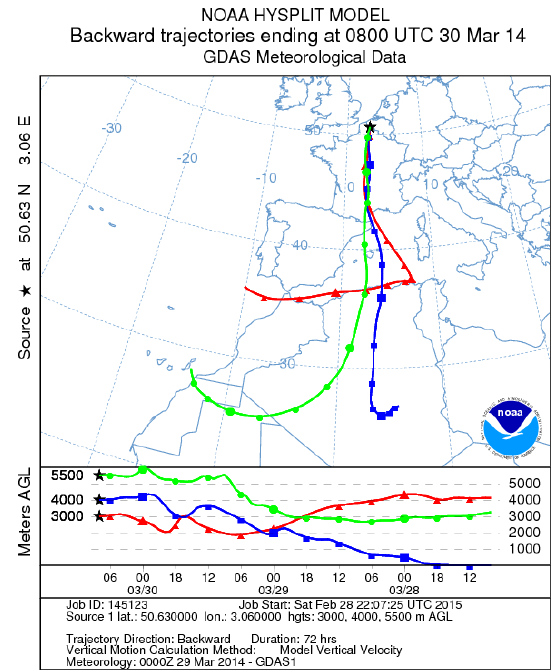
Figure 2. Backward trajectories of air masses observed over Lille during the morning of 30 March